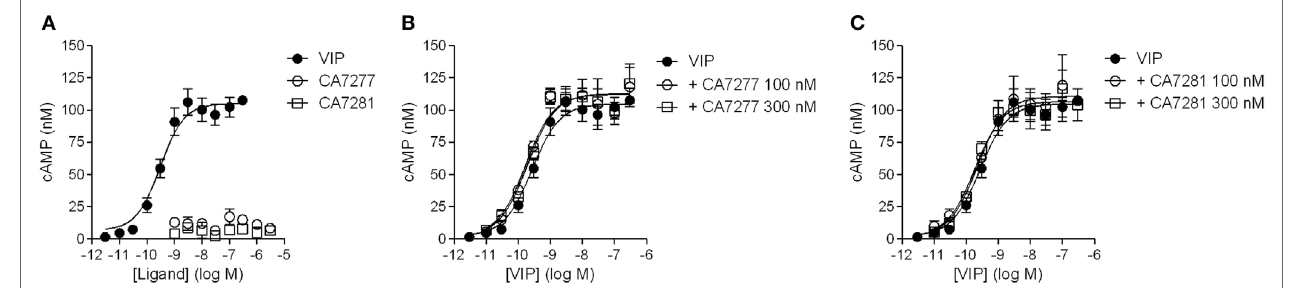
FigUre 5 | Effect of nanobodies on cAMP accumulation. (a) Cyclic AMP accumulation in the presence of VIP (filled circles), CA7277 (open circles), or CA7281 (open squares) in CHO cells expressing VPAC1 (left panel). Effect of CA7277 (B) or CA7281 (c) at 100 or 300 nM on cAMP accumulation promoted by increasing concentrations of VIP in the same cells. The results are the means ± SEM of three independent experiments performed in